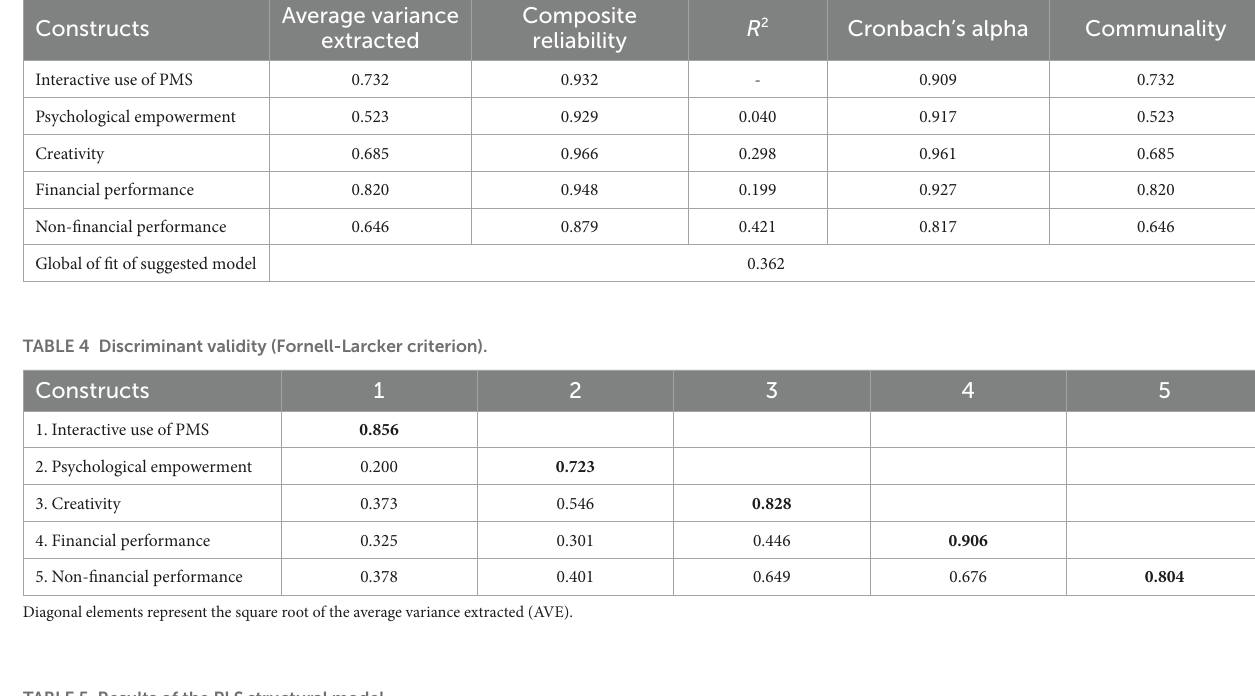
TABLE 5 Results of the PLS structural